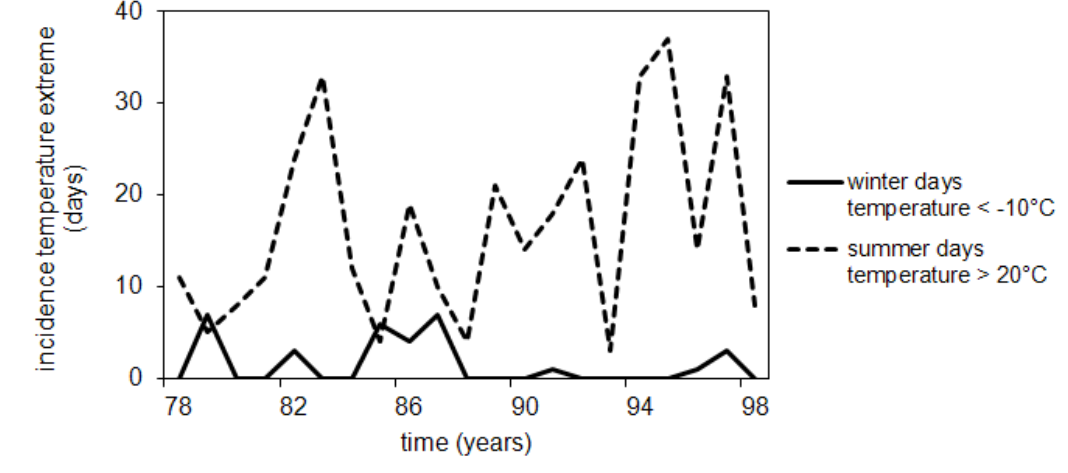
) incidence during the summer vegetation 95